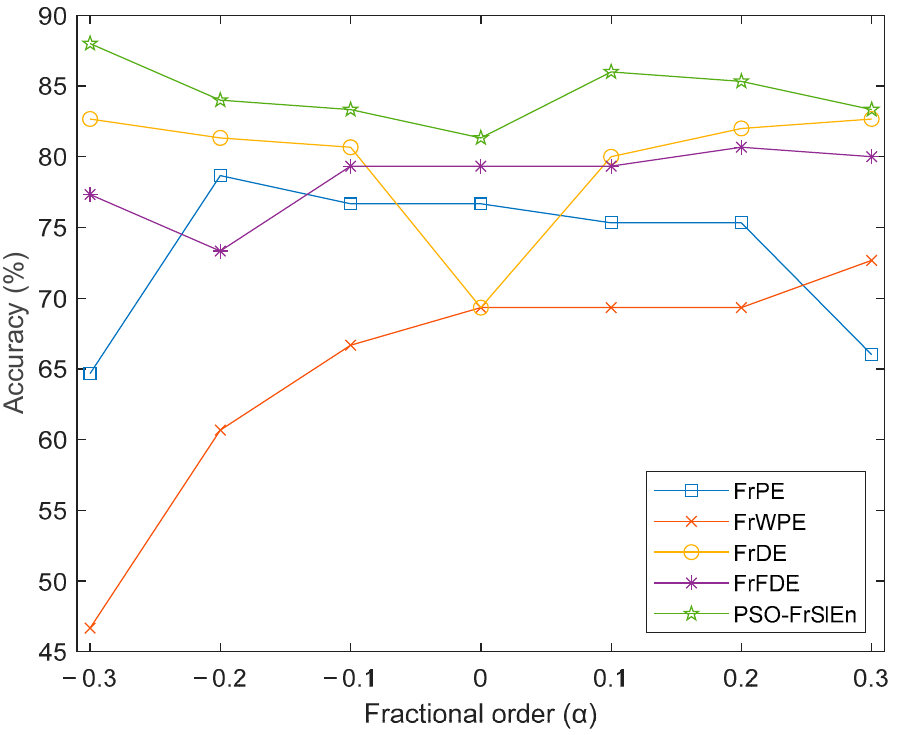
Figure 7. The classification accuracies under different fractional orders.